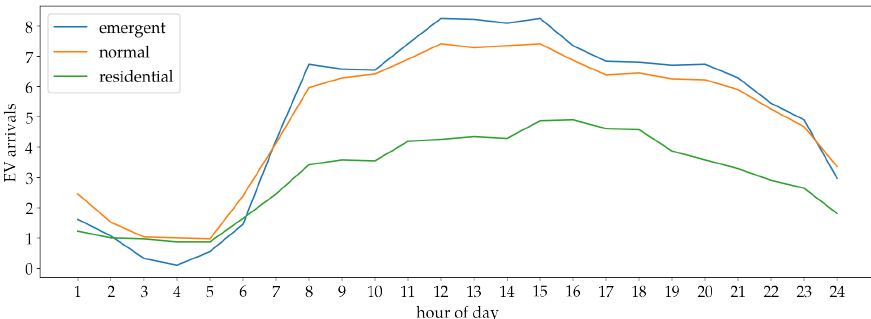
Figure 4. Average EV arrivals per hour of day per charging profile.